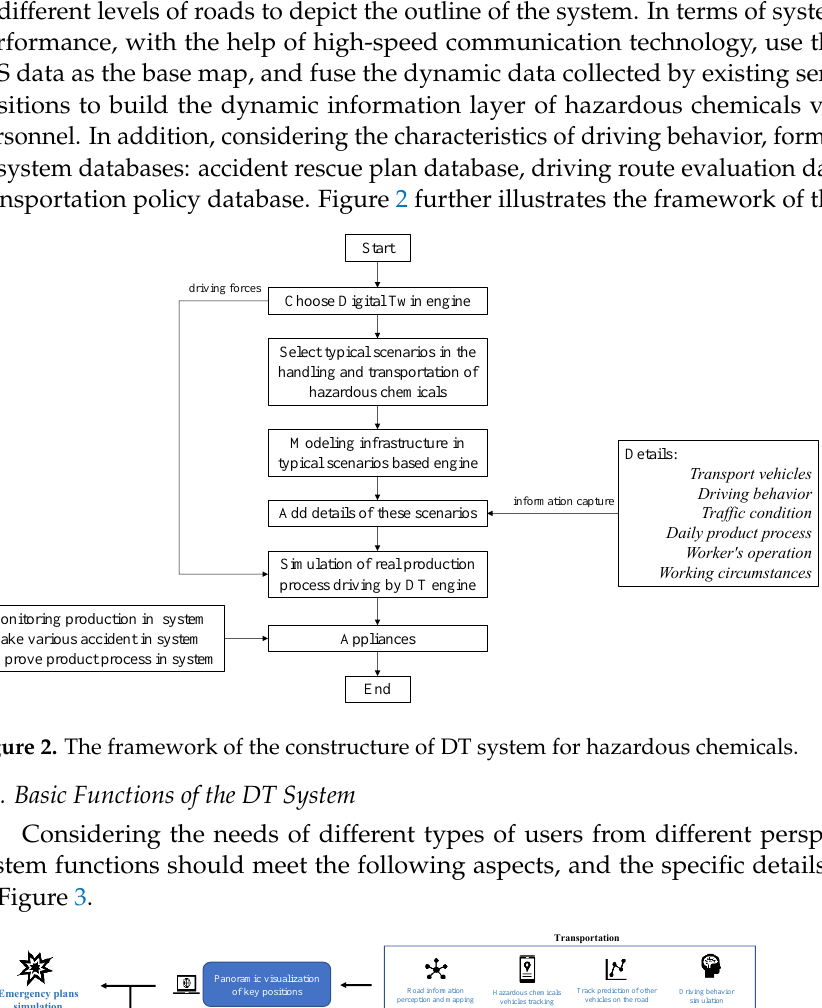
Figure 1. Overview of the hazardous chemical storage and transportation sensor system.